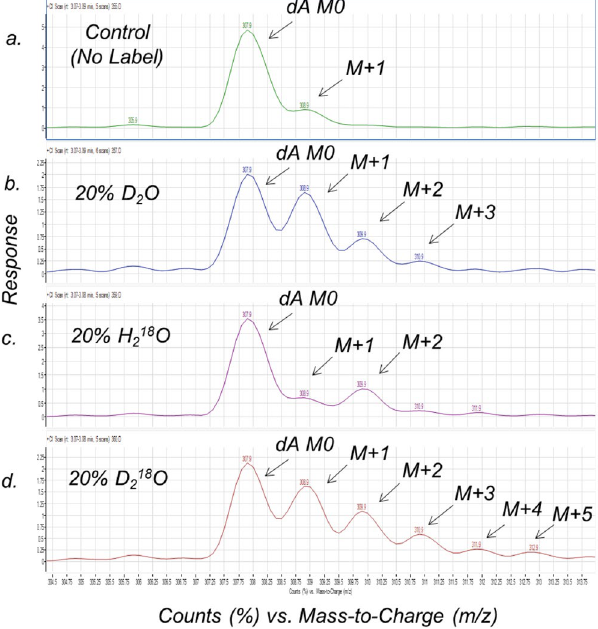
Figure 2. Mass spectrometry isotopic signatures (normalized to dA M0) for heavy water enrichment into mouse thymus tumor cell DNA base deoxyadenosine (dA) after 3–5 days of incubation. ( a ) Mouse thymus tumor cells incubated in cell media demonstrating the natural isotopic abundances of the MethElute ™ derivative of dA, with molecular weights of dA M0 (308 m/z) and dA M + 1 (309 m/z). ( b ) Isotopic enrichments (M + 1, M + 2, M + 3) of the tumor cells incubated in cell media fortified with 20% D 2 O (v/v). ( c )